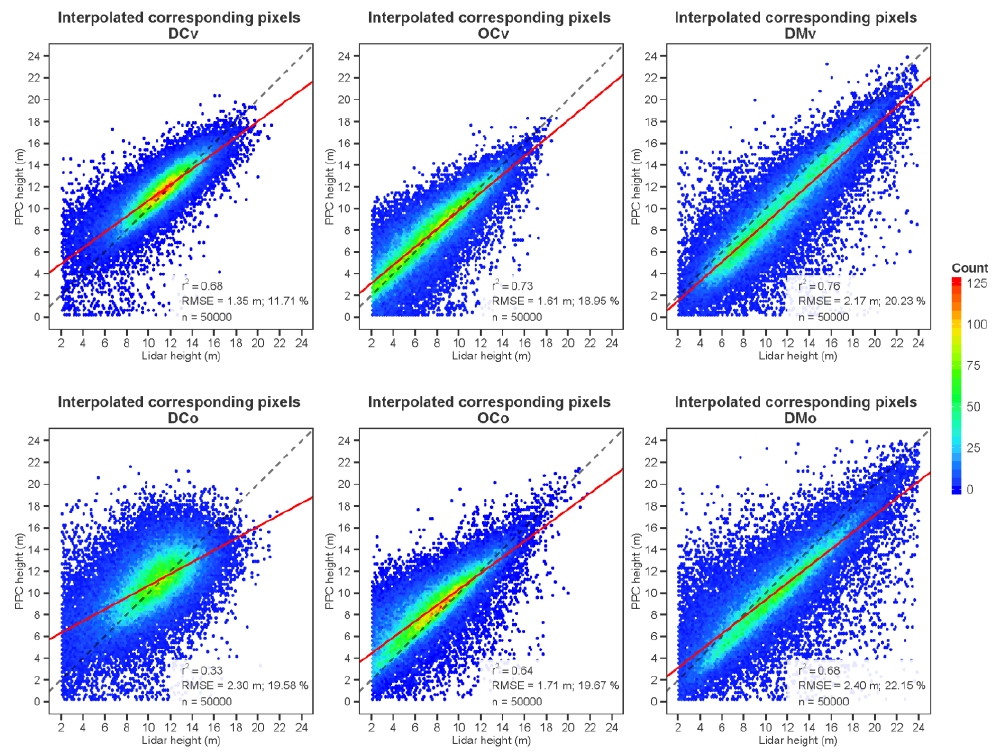
Figure 6. Scatterplots of the height correspondence between lidar and photogrammetric interpolated CHMs (red line represents the slope of the relationships and dashed line represents the 1:1 relationship).